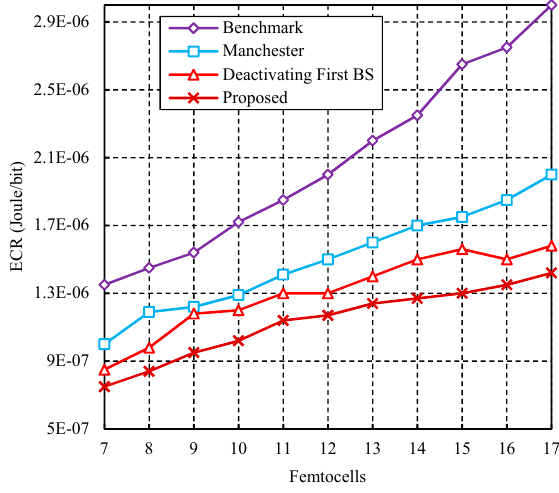
Figure 5. Comparisons of ECR (Jolues/bit) with different cell densities.